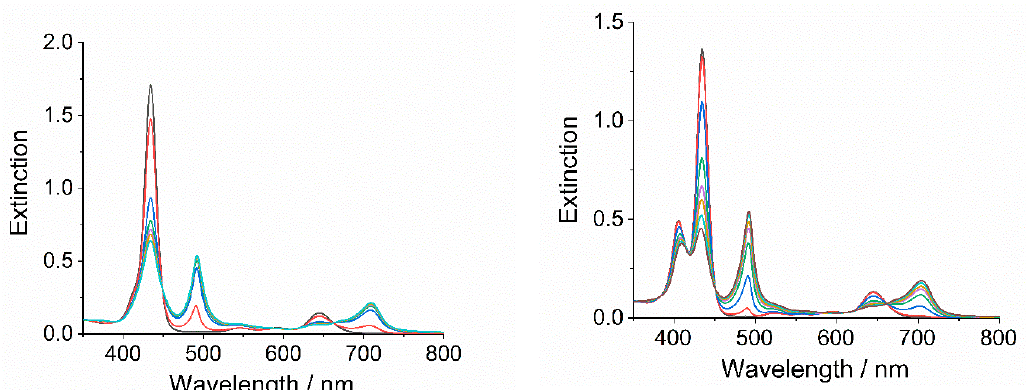
Figure 1. UV/Vis extinction spectral changes for the aggregation of TPPS 4 into J-aggregates in the presence of CoT 4 ( left ) and AuT 4 ( right ) after the addition of hydrochloric acid. For CoT 4 : 0 (black), 40 (red), 80 (blue), 120 (green), 160 (violet), 210 (yellow), 340 s (cyano); For AuT 4 : 0 (black), 10 (red), 20 (blue), 30 (green), 40 (violet), 50 (yellow), 80 (cyano), 220 s (brown). (Experimental conditions: [TPPS 4 ] = 3 µ M; [MT 4 ] = 1.5 µ M; [HCl] = 0.00158 M, T = 298 K, total acquisition time 400 s).